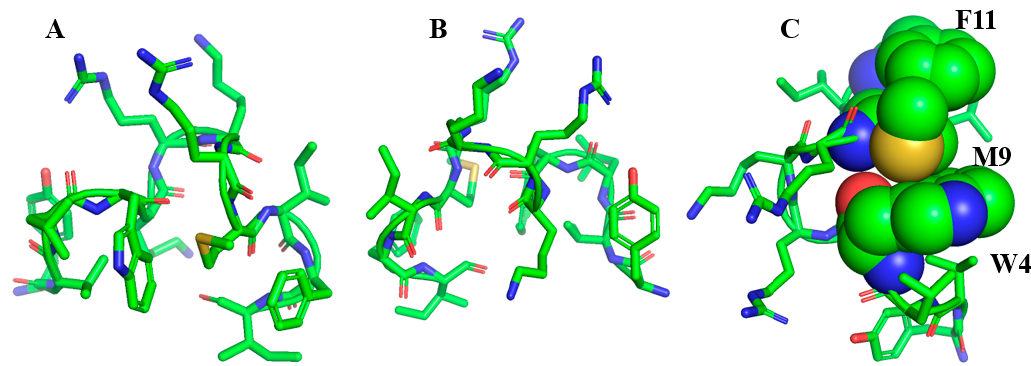
Figure 3. Structure of YW12 in LPS (pdb accession code: 2O0S): the β -boomerang shape inspired the design of the other peptides listed in Table 3. Sidechain dispositions of the β -boomerang structure are shown in two di ff erent orientations ( A , B ). The designed peptide assumed an amphipathic structure, with the central cationic residues K 5 RKR 8 exposed to the outer periphery, whereas the N- and C-termini aromatic and non-polar residues sustained inward packing interactions. ( C ) Sidechains of residues W4, M9, and F11 of YW12 are in close packing interactions that are found to be critical for the activity.